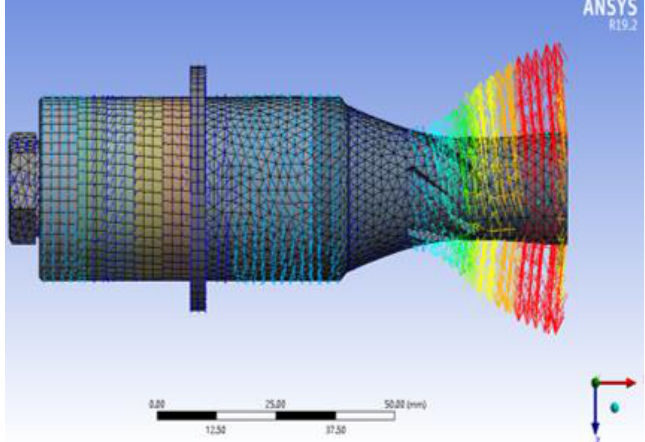
Figure 8. Modal velocity vector diagram of longitudinal – torsional transducer.